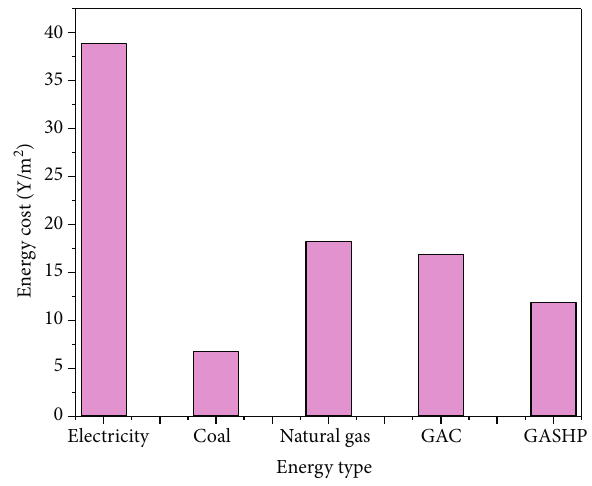
Figure 14: Heating cost of various energy sources.